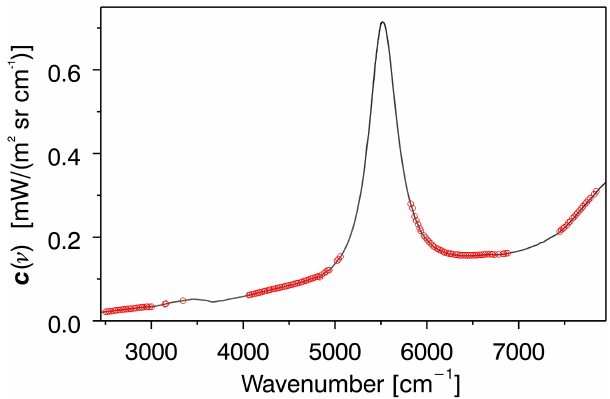
Figure 4. Blackbody radiance spectrum recorded on 24 Febru- ary 2014 with a cavity temperature of 1923.15K. Grey: measured spectrum; black: result of spectral line exclusion; red: final spectrum after median filtering.